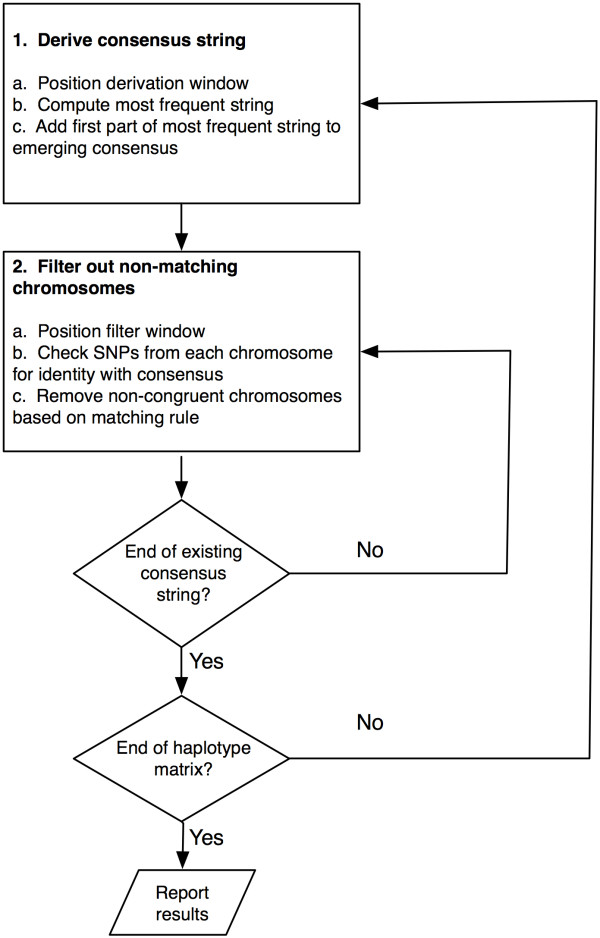
Flow chart of ExHap algorithm. This figure provides a high-level conceptual overview of the congruence finding algorithm. First, a consensus string is identified for a short section of the chromosomes under consideration. Second, chromosomes which do not match this consensus are eliminated from further consideration. The process repeats until the end of the overall region is reached